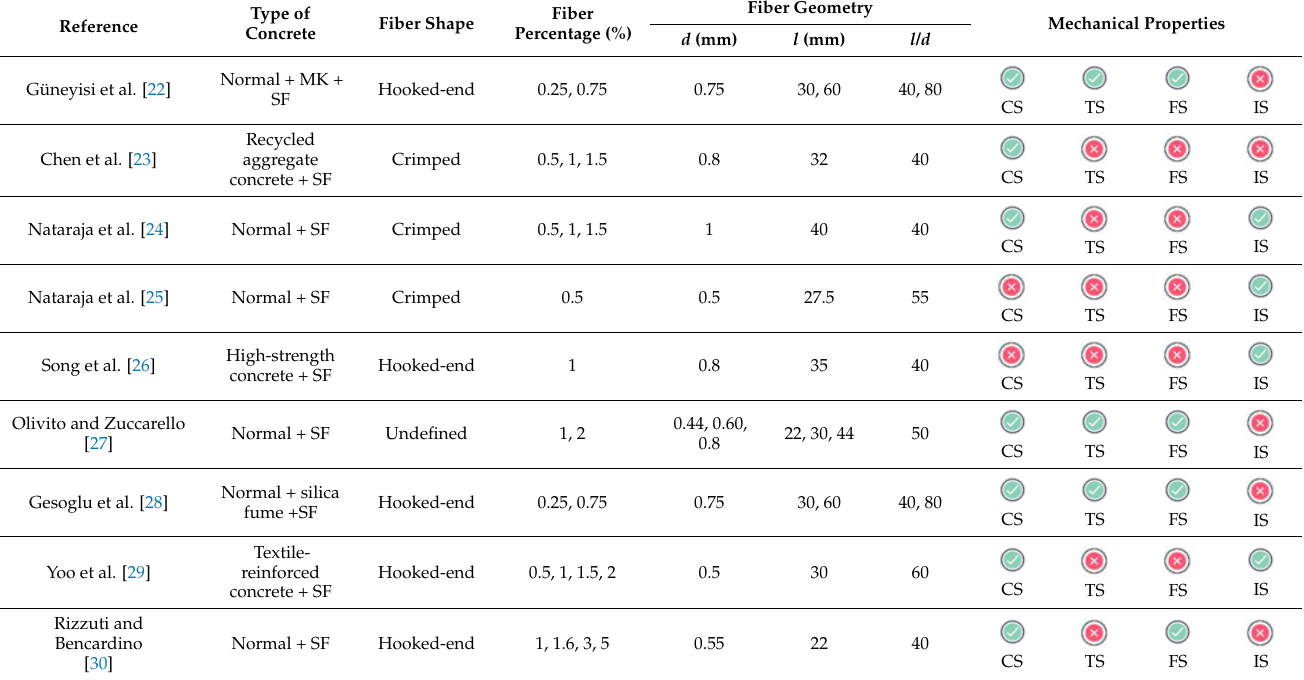
Table 1. Information on previous studies.